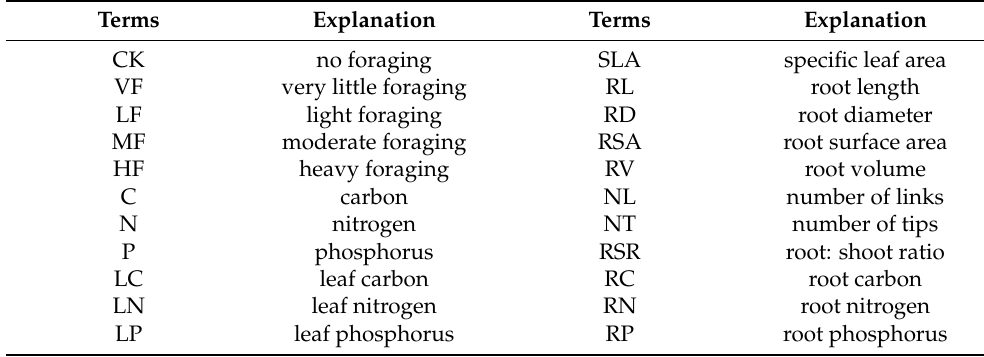
(Table 1). We harvested the leaves and roots of C. thunbergii on 24 March 2021. Table 1. The parameters of foraging intensity and the measurement Table 1. The parameters of foraging intensity and the measurement index.